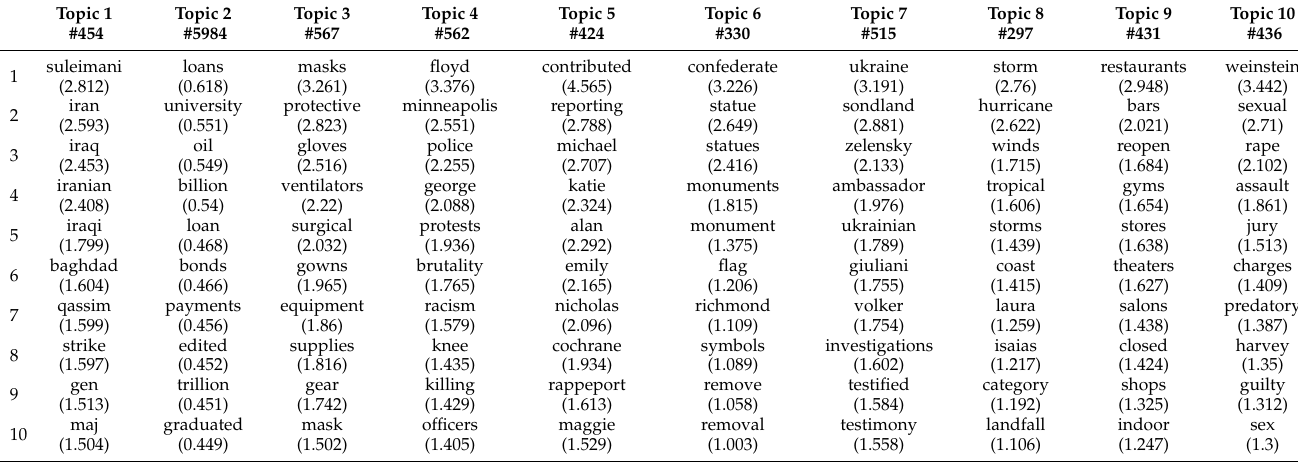
Table 12. Top 10 representative words per dimension of the basis matrix A , trained on the New York Times news article data as input tensor using multiplicative update